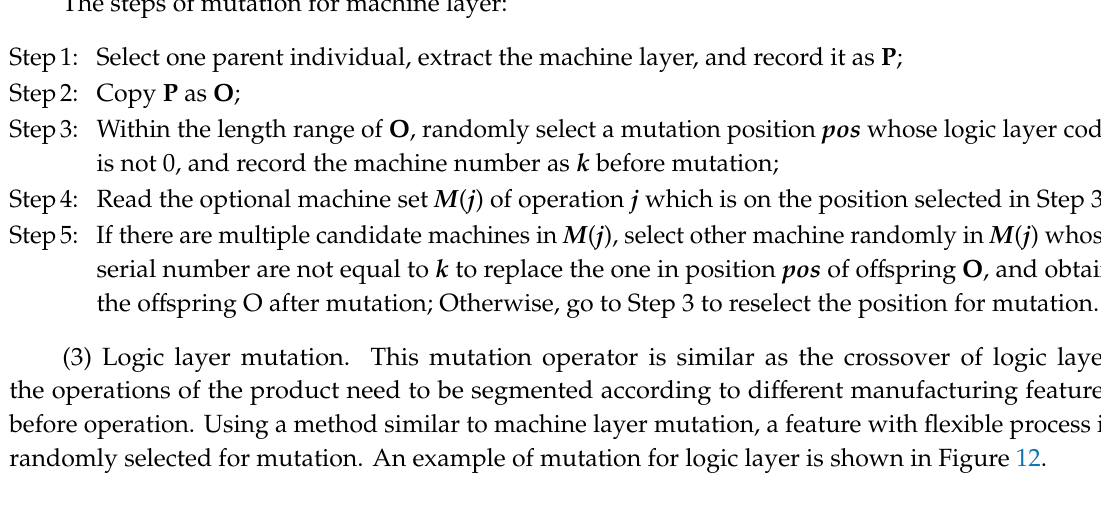
Figure 11. An example of mutation for machine layer.